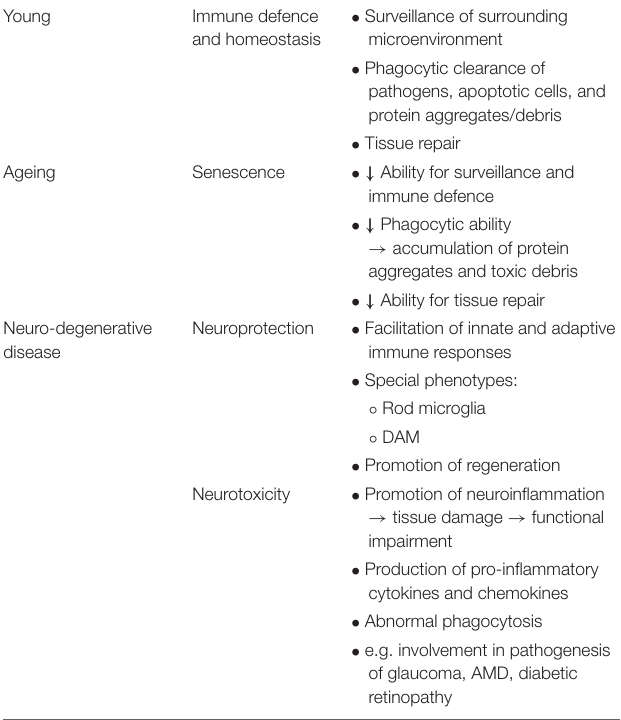
TABLE 1 | Overview of the possible roles and behaviour of microglia in the young retina, ageing retina, and retinal neurodegenerative disease.